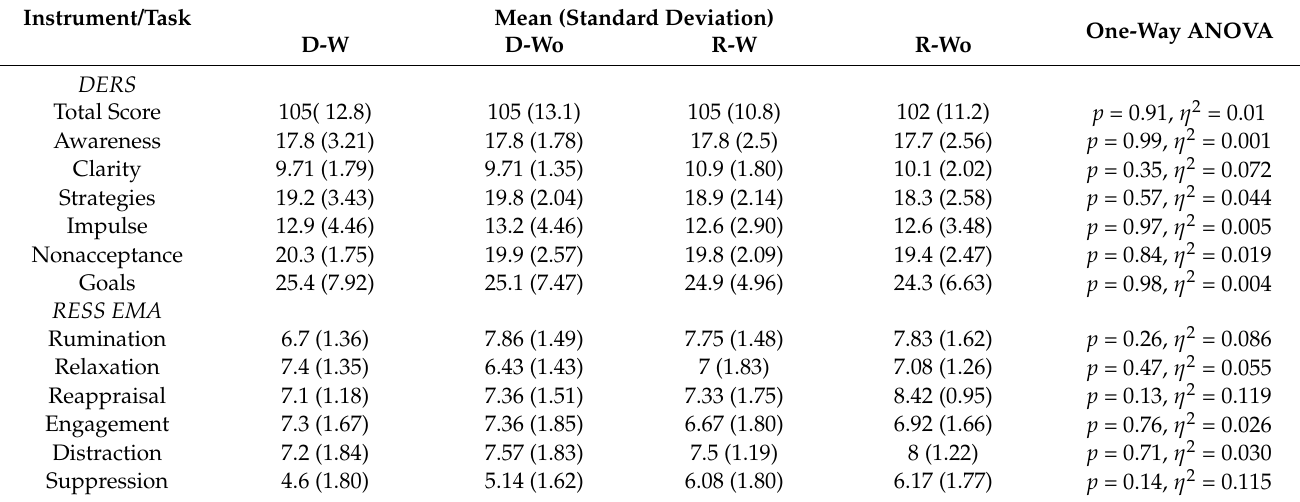
Table 2. Emotional regulation skills across experimental groups.